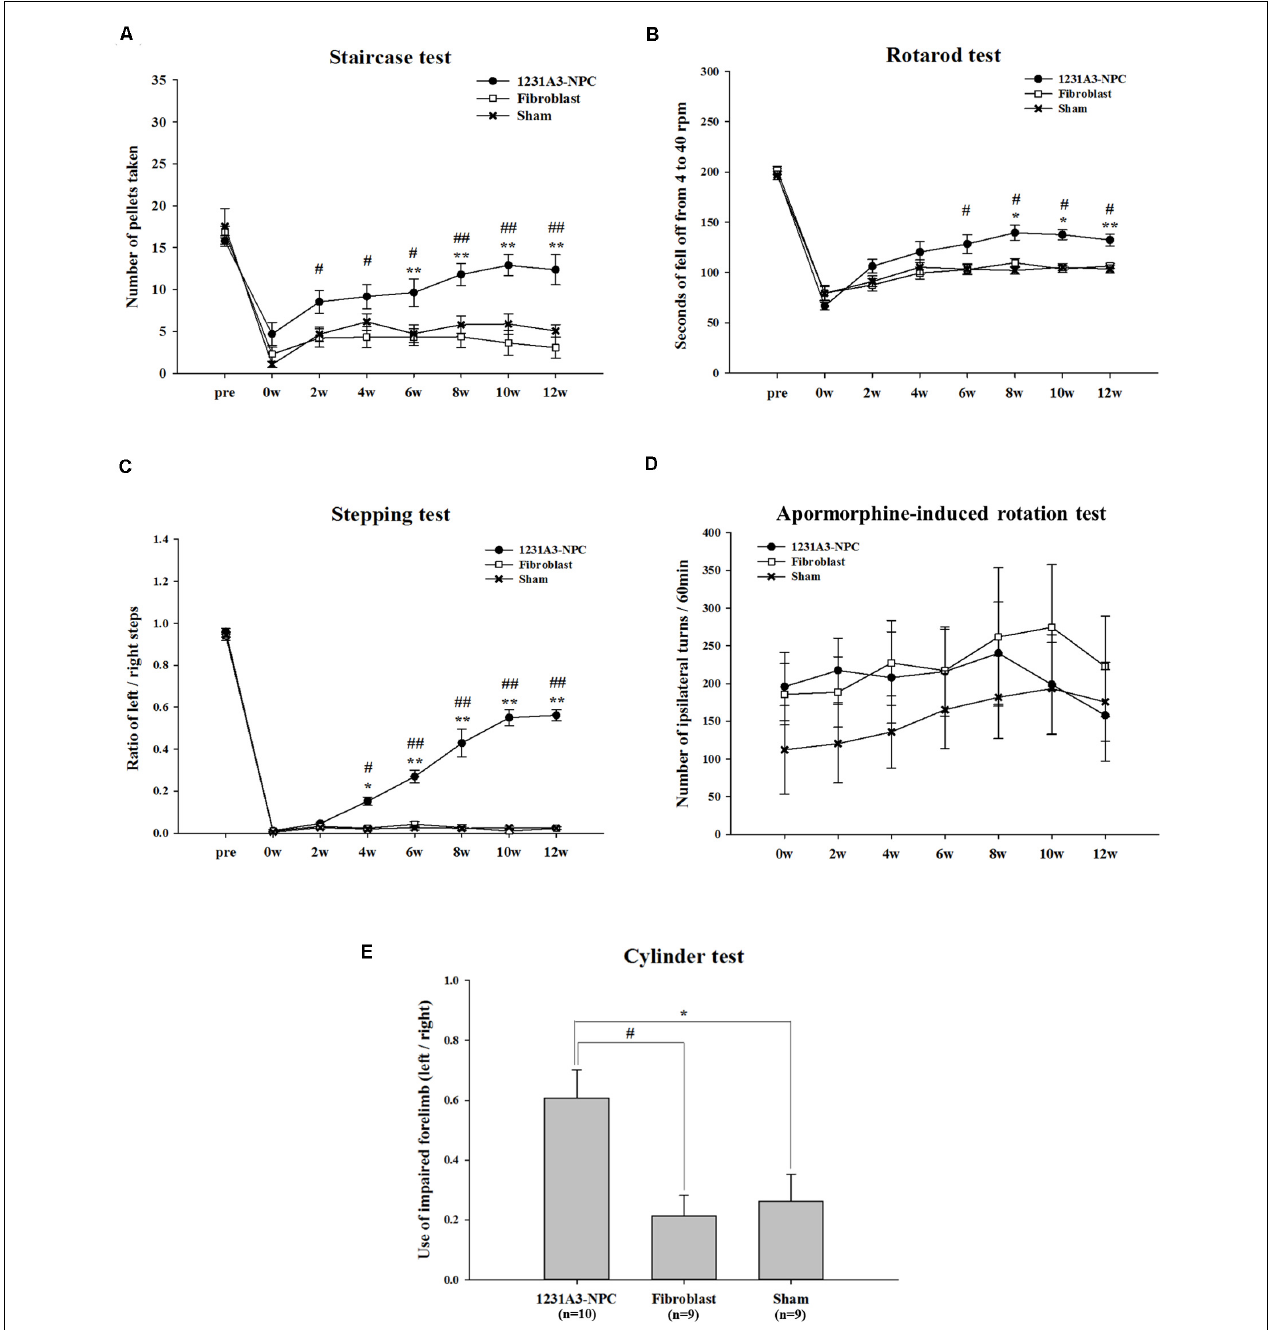
FIGURE 1 | Results of behavioral assessment in the 1231A3-NPC TP, fibroblast TP, and sham groups after TP into the QA-lesioned rat model. (A) Staircase test. (B) Rotarod test. (C) Stepping test. (D) Apomorphine-induced rotation test. (E) Cylinder test. n = 10, 9, and 9 in the 1231A3-NPC TP group, fibroblast TP group, and sham group, respectively. [1231A3-NPC TP vs. fibroblast TP ( # p < 0.05; ## p < 0.001), 1231A3-NPC TP vs. sham (* p < 0.05; ** p < 0.001)]. NPCs, neural precursor cells; TP, transplantation; QA, quinolinic acid.